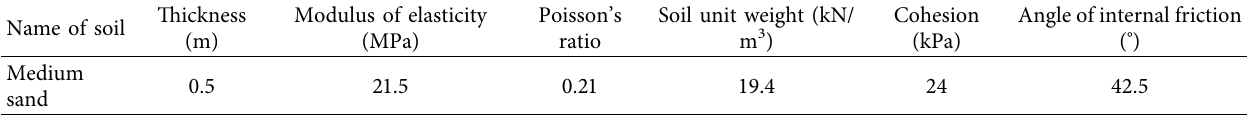
Table 2: Medium sand parameters [24].